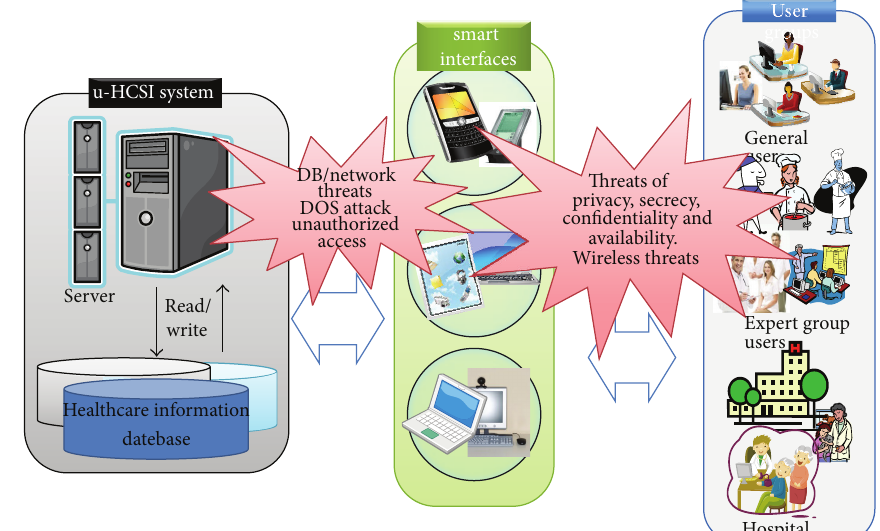
Figure 5: Security threats to u-healthcare service